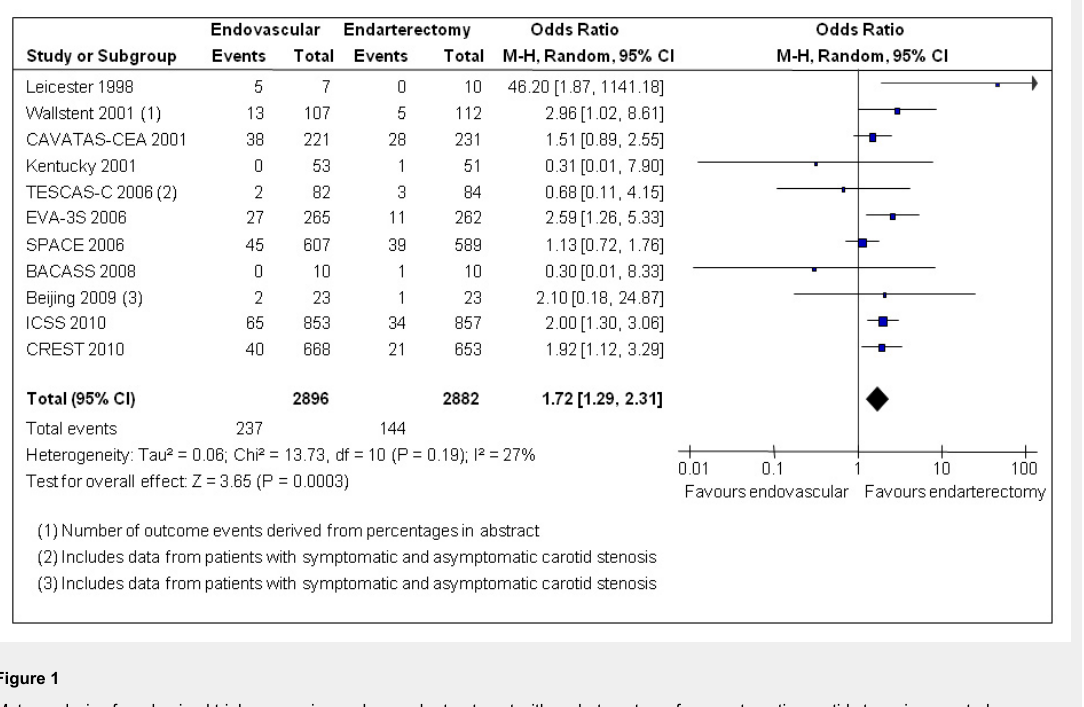
Meta-analysis of randomised trials comparing endovascular treatment with endarterectomy for symptomatic carotid stenosis: any stroke or death between randomisation and 30 days after treatment. Data are numbers of patients with events, total numbers of patients and Mantel- Haenszel random-effects odds ratios including 95% confidence intervals (CI) for any stroke or death occurring between randomisation and 30 days after treatment, with endarterectomy as the reference treatment. Squares on the right represent point estimates of odds ratios at trial level, with 95% CI as horizontal bars. The diamond at the bottom represents the summary OR and 95% CI. Data from the following trials are included: Leicester [46], Wallstent [47], CAVATAS [13], Kentucky [48], TESCAS-C [49], EVA-3S [14], SPACE [16], BACASS [50], Beijing [51], ICSS [17], CREST